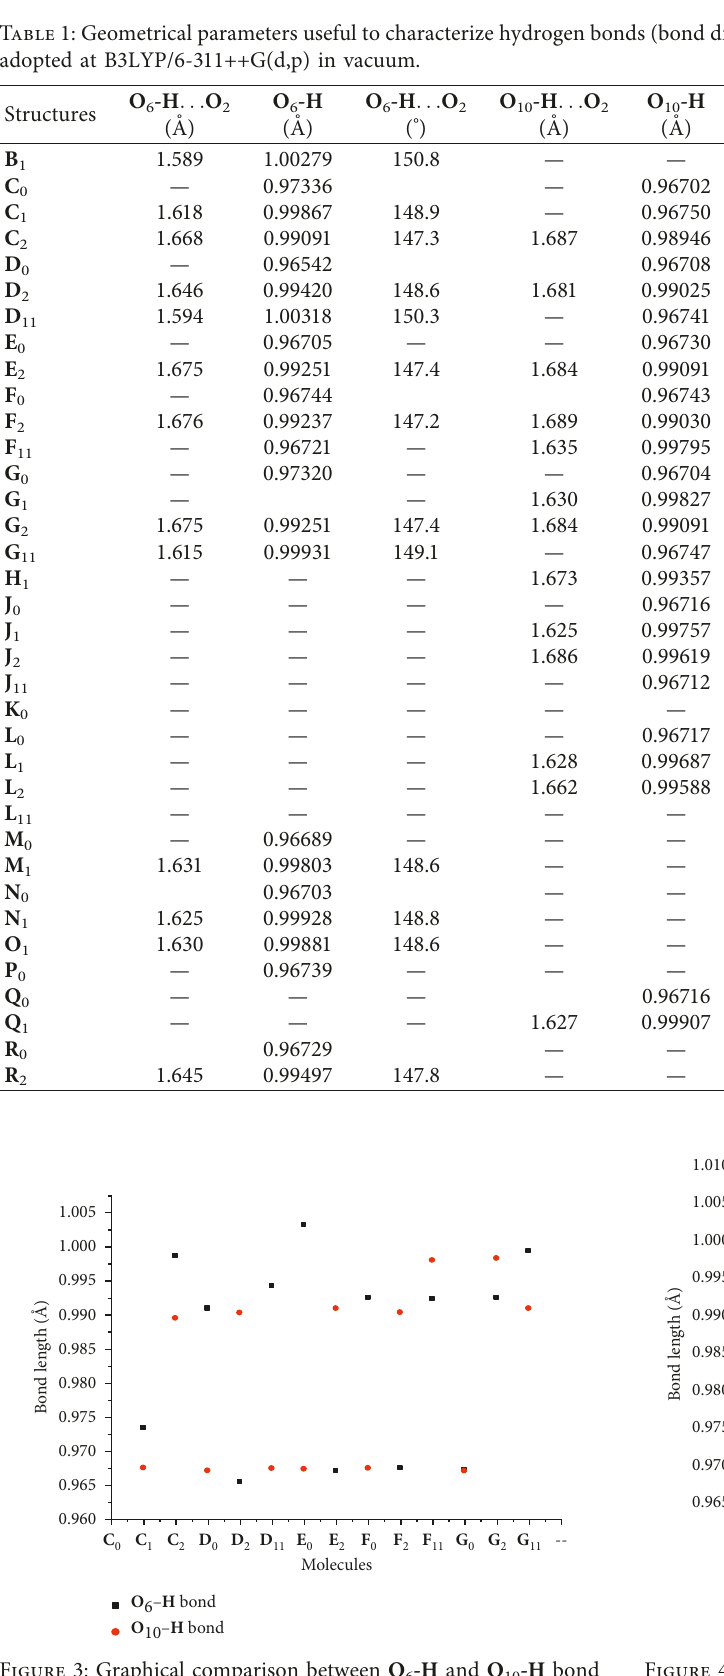
6 -H and O 10 -H bond